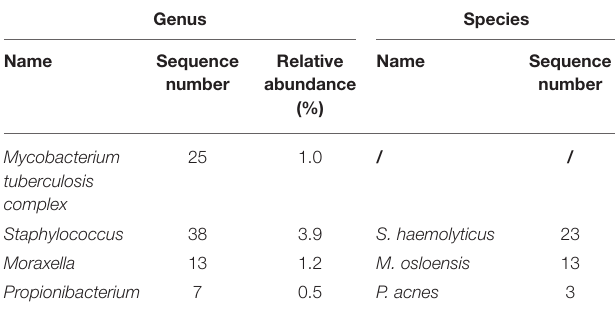
FIGURE 1 | enhancement in the left posterior mediastinum. (C) MRI of thoracic spine revealed a soft tissue lesion (white arrow) at T3/T4. (D) MRI of thoracic spine showed a soft tissue lesion (white arrow) at T7/T8. (E) MRI of thoracic spine displayed multiple bone destructions (white arrows) at T3/T4 and T7/T8 with surrounding soft tissue lesions. (F) Radionuclide bone scan showed that the metabolism of vertebral bodies of T4 and T8 was abnormal. (G) Histopathological examination of the lesion at T7/T8 showed caseous necrosis with a significant number of inflammatory cells and multinucleate giant cells. CT, computed tomography; F-18 FDG-PET,